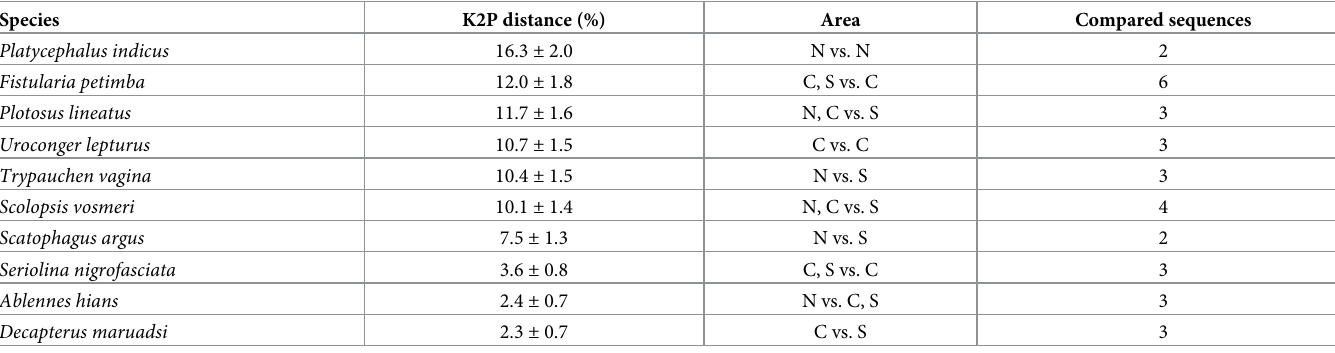
Table 3. Summary of K2P genetic divergences of 10 species with intraspecific distances more than 2%. Species K2P distance (%) Area Compared sequences Platycephalus indicus 16.3 ± 2.0 N vs. N 2 Fistularia petimba 12.0 ± 1.8 C, S vs. C 6 Plotosus lineatus 11.7 ± 1.6 N, C vs. S 3 Uroconger lepturus 10.7 ± 1.5 C vs. C 3 Trypauchen vagina 10.4 ± 1.5 N vs. S 3 Scolopsis vosmeri 10.1 ± 1.4 N, C vs. S 4 Scatophagus argus 7.5 ± 1.3 N vs. S 2 Seriolina nigrofasciata 3.6 ± 0.8 C, S vs. C 3 Ablennes hians 2.4 ± 0.7 N vs. C, S 3 Decapterus maruadsi 2.3 ± 0.7 C vs. S